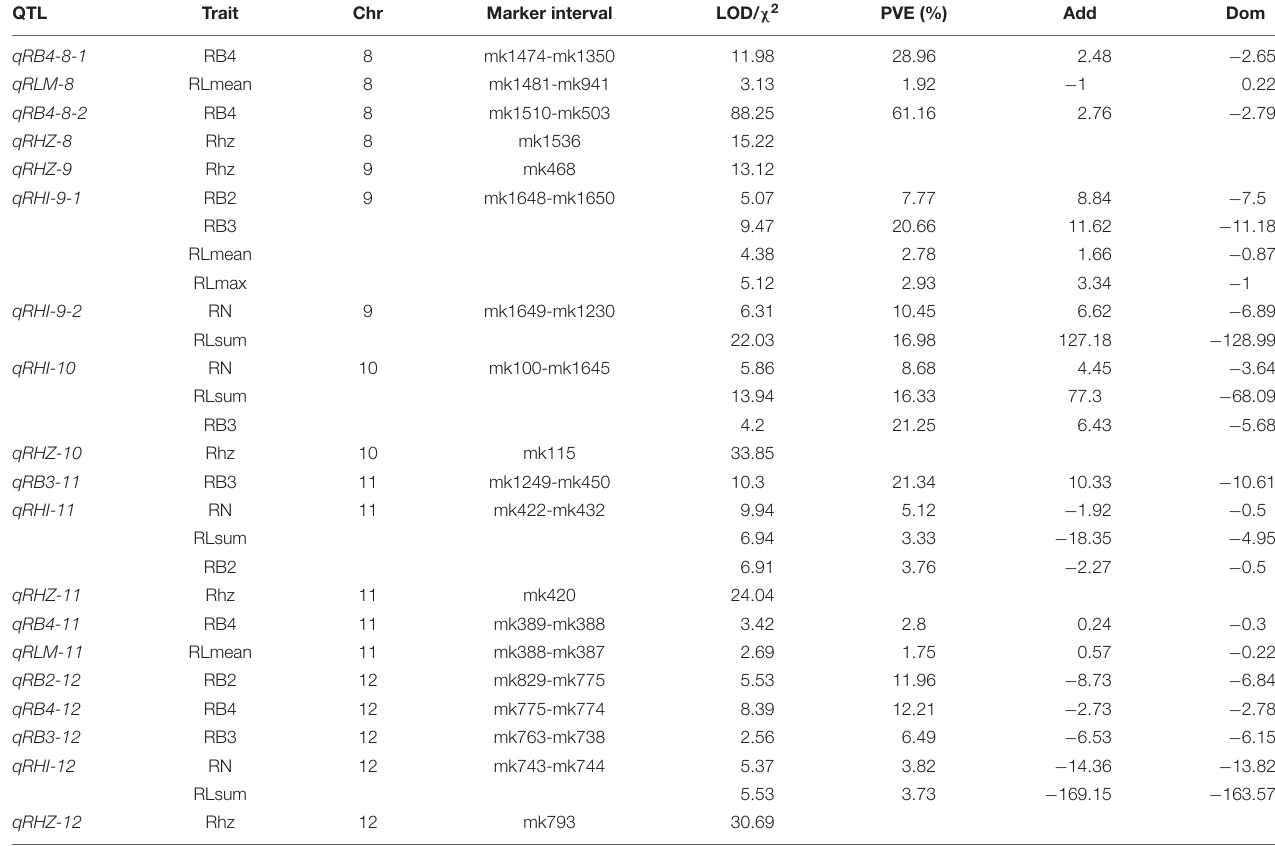
(38 markers), with the average distance being 0.92 cM ( Figure 3 and Supplementary Table 3